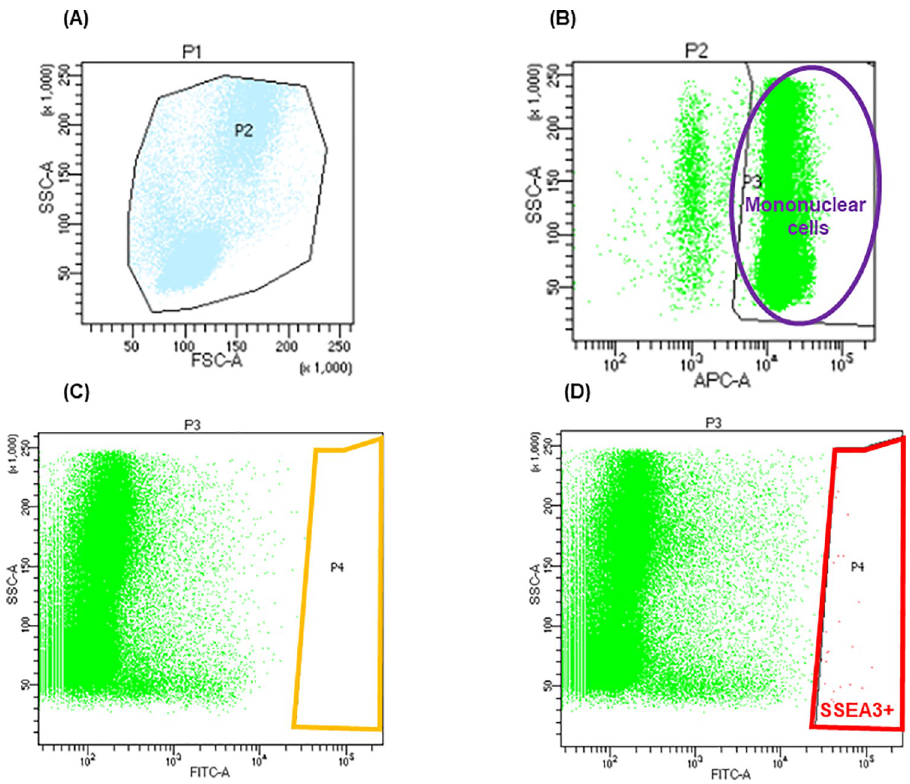
Fig 1. How to count SSEA3 positive Muse cells using fluorescence-activated cell sorting (FACS). A: The mononuclear cell fraction after Lymphoprep ™ treatment was roughly selected by forward scatter and side scatter gating. B: The few remaining red blood cells (negative for NucRed ™ Live647) were removed by specific gravity centrifugation. C: Nonspecifically labeled cells were removed based on the isotype control. D: The gating was set for SSEA-3 +